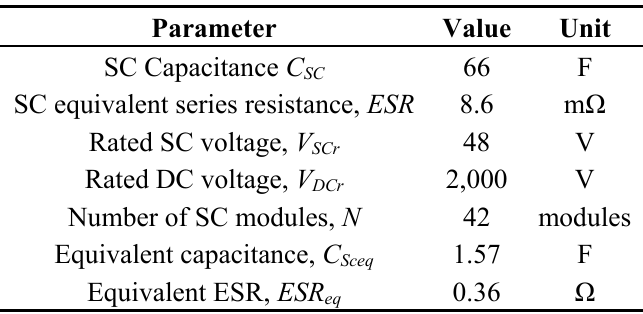
Table A6. DC link supercapacitor, German